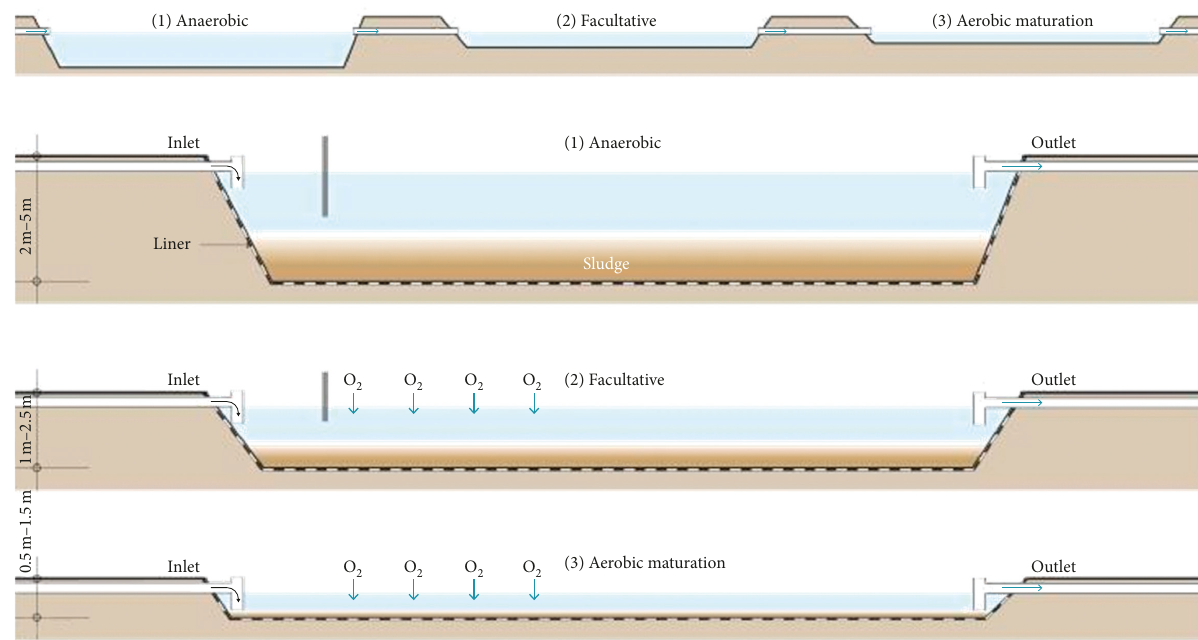
Figure 3: Waste stabilization ponds.